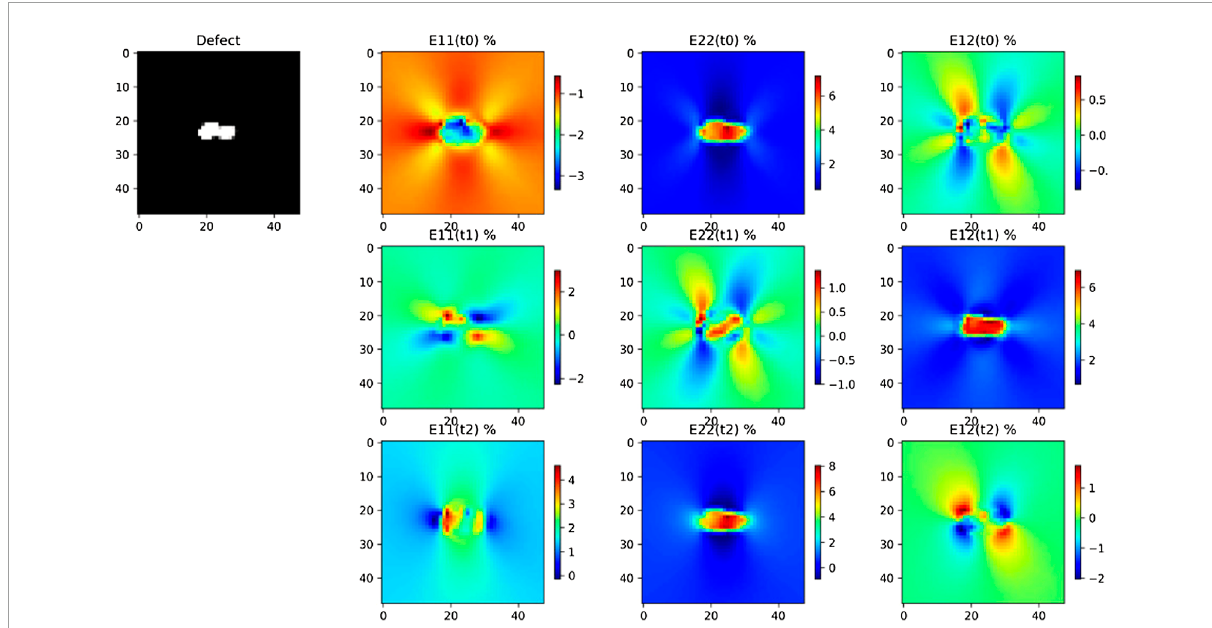
FIGURE 7 Strain components of the LROM for digital twin i = 1: on the top left, μ □ ; on the right, ε ( V ( 1 ) ) . Here, t 0, t 1, and t 2 stand for the indices of the vectors that span the LROM.